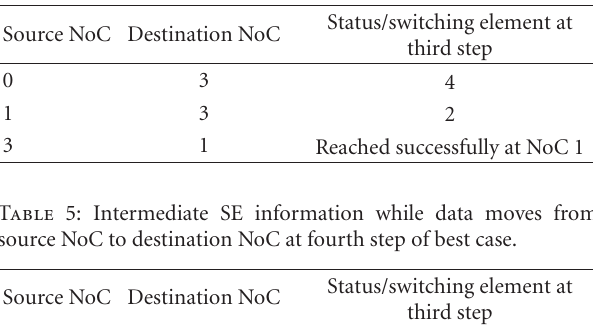
Table 4: Intermediate SE information while data moves from source NoC to destination NoC at third step of best case.